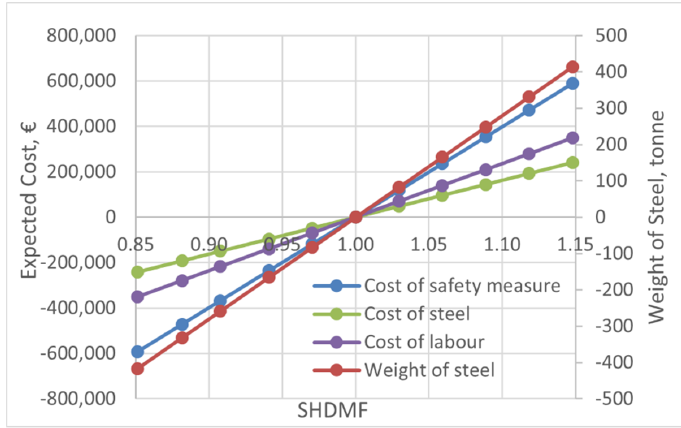
Figure 5. Safety measures, steel and labour cost, and weight of steel.